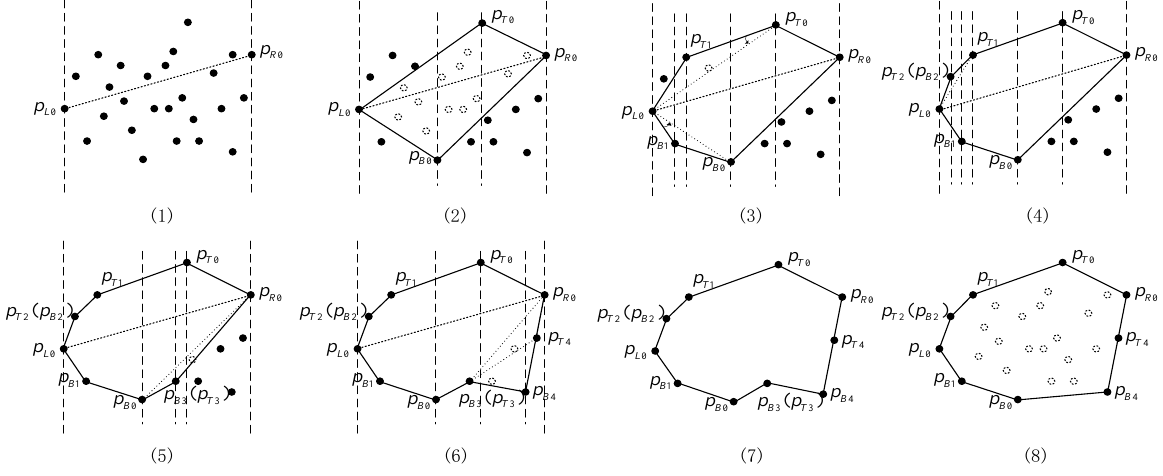
Figure 3. Generation process of the initial